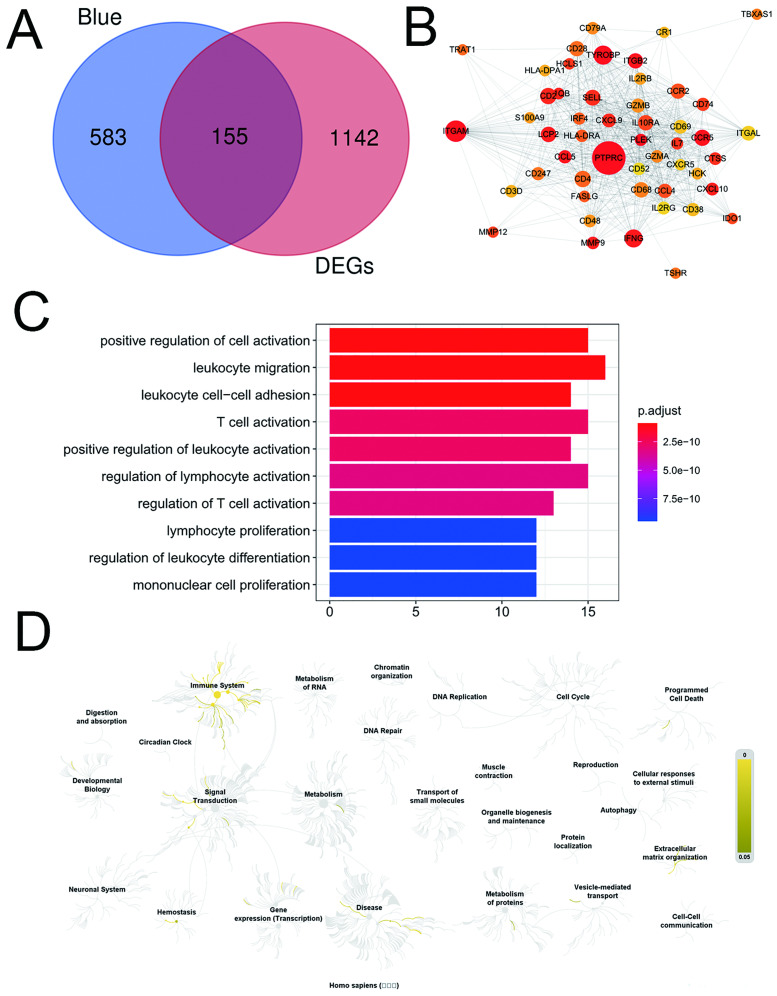
Identification of hub biomarkers.(A) Venn plot of common genes. (B) Top 50 genes by highest BC obtained from PPI network analysis. (C) Biological process enrichment analysis for the top 50 genes. (D) REACTOME Pathway enrichment analysis for the top 50 genes.